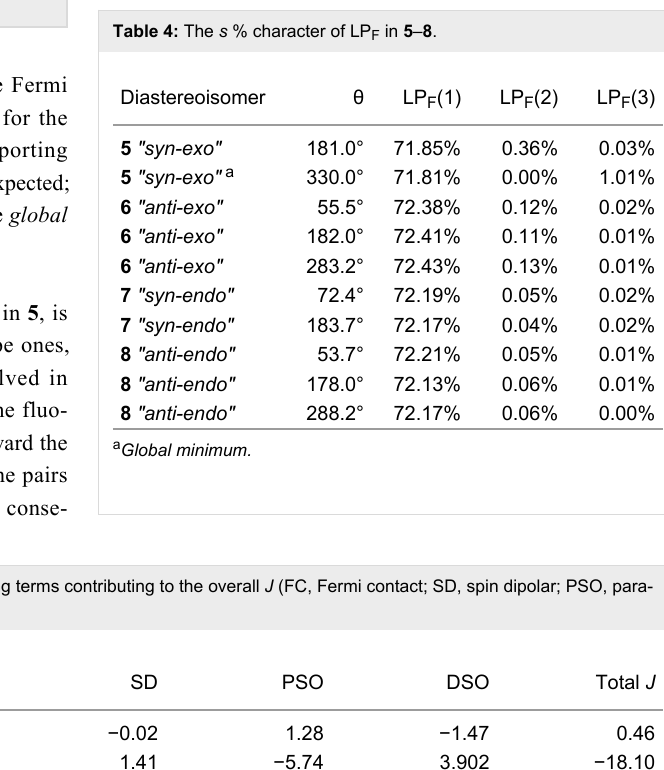
Diastereoisomer